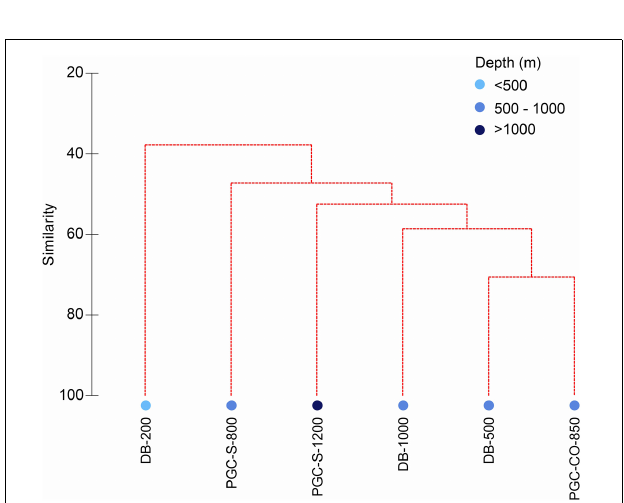
FIGURE 4 | PGC molluscan similarity species cluster analysis by station (DB, Duse Bay; PGC, Prince Gustav Channel; S, South; CO, Cape Obelisk). Square root transformation and Bray Curtis similarity of resemblance.